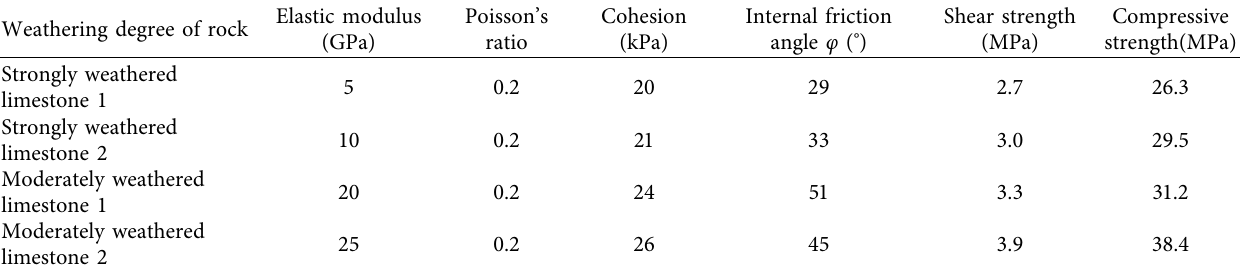
Table 2: Mechanical parameters of materials in the blasting excavation area.